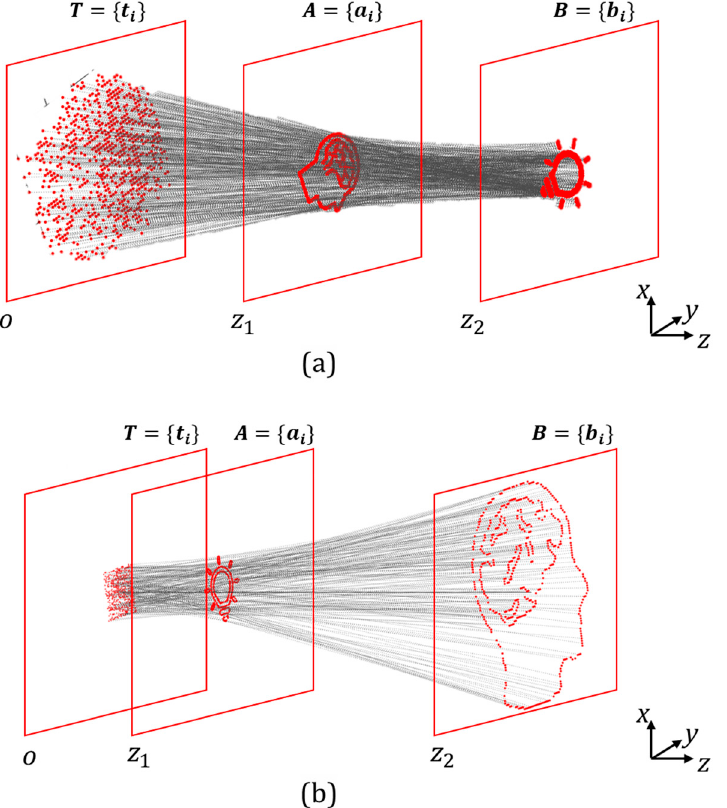
Figure 5. Proposed speckle noise-free interconnective holographic projection on multi-depth planes. ( a ) Collimated interconnective holographic projection and ( b ) diverging interconnective holographic projection. Algorithm 1 suggests several possible interconnection combinations as n × m × k matrices. It determines the possible interconnection between two points on each image plane. Additionally, it excludes combinations in which the slope of the straight line con ‐ taining two points is greater than the tilting angle expressed by the goniometer meter. Algorithm 2 chooses a combination of possible features. In Algorithm 2, P indicates the number of connections. Algorithm 1: Count optical interconnection combination.